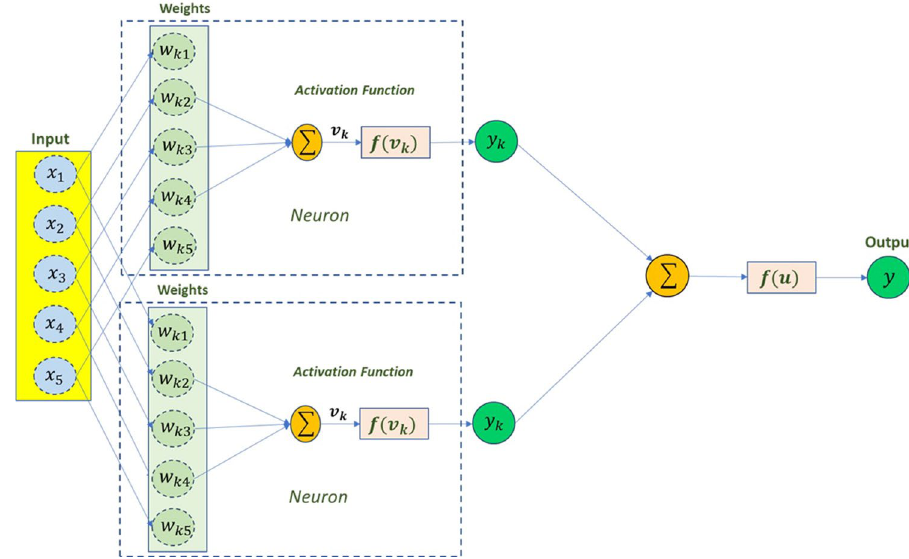
Fig. 5 Neural network typical